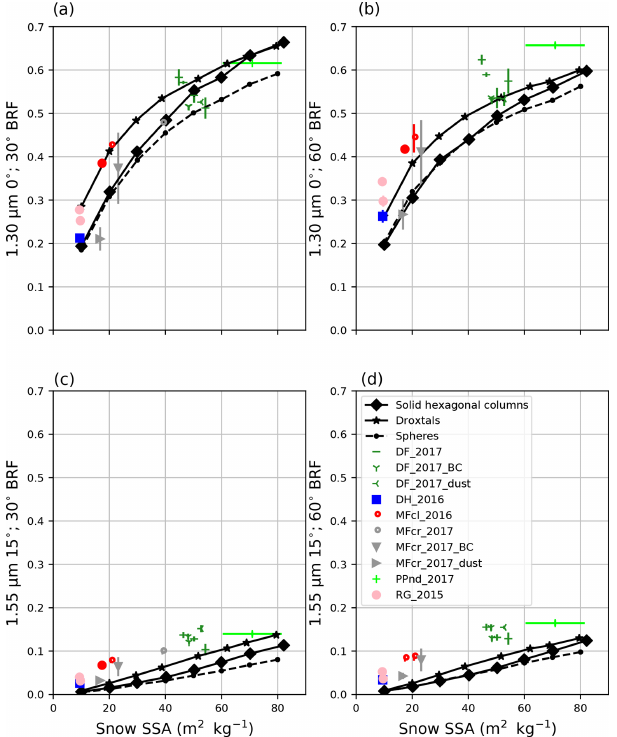
Figure 4. NERD SSA calibration. All panels contain NERD- measured and Monte Carlo-modeled (black) BRFs (1.30µm, a, b ; 1.55µm, c, d ; 30 ◦ viewing, a, c ; 60 ◦ viewing, b, d scattered against snow SSA. NERD BRFs are scattered against X-CT-derived snow SSA. Line segments connect Monte Carlo modeled BRFs of snow media comprised of spheres (filled circles, dashed lines), droxtals (stars, solid lines), and solid hexagonal columns (diamonds, solid lines). Snow sample key codes, symbols, and colors conform with the physical snow classification standards defined by Fierz et al. (2009) (Table 2). Vertical error bars on NERD BRFs represent stan- dard deviations calculated from multiple azimuthal samples. Hor- izontal error bars on X-CT-derived SSA, where present, represent standard deviations from multiple scans on similar snow